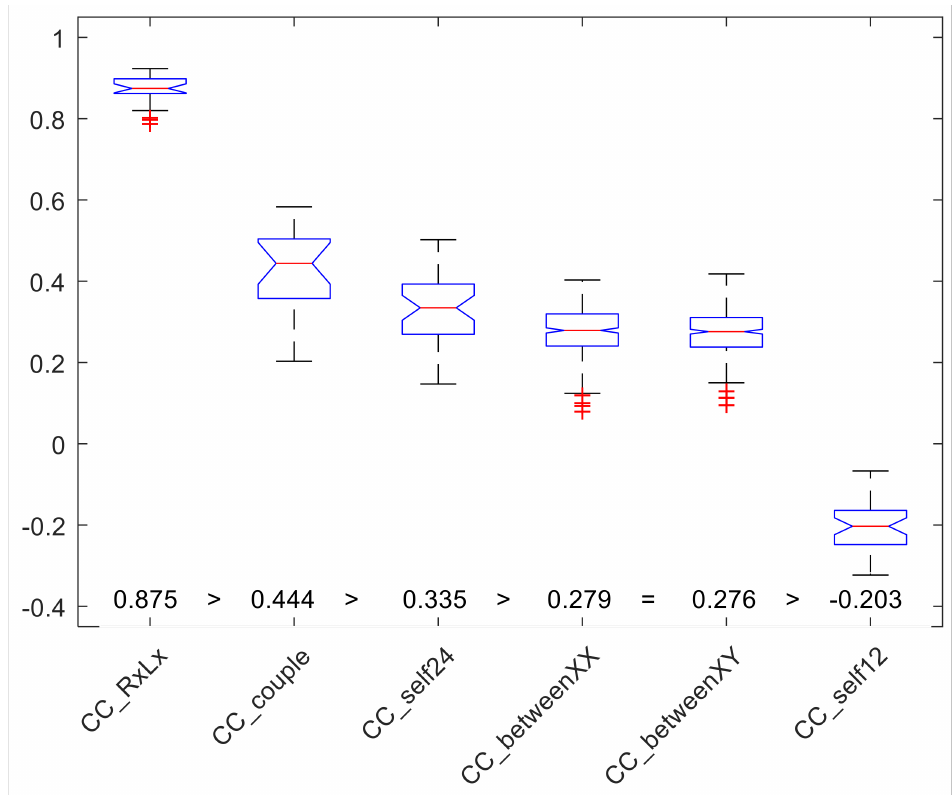
Figure 3. Bar plots of the CC values grouped according to the conditions considered (plotted values include median, reported also as numerical values, first and third quartiles, nonoutlier extremes, and, where present, outliers as “+”). The statistical analysis (Kruskal–Wallis, ANOVA, and Wilcoxon– Mann–Whitney post-hoc tests) evidenced that all conditions have different values compared to the other groups (the only exception is that CC betweenXX and CC betweenXY did not show different values). Median values are reported just above the x -axis labels, with significant differences between groups. The CC RxLx group is presented as a reference, derived from a different data set published elsewhere